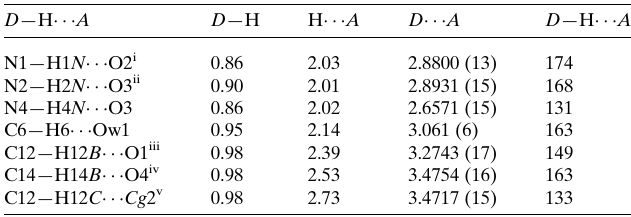
Table 1 Hydrogen-bond geometry (A˚ , (cid:3) ). Cg 2 is the centroid of the C5–C10 benzene ring.